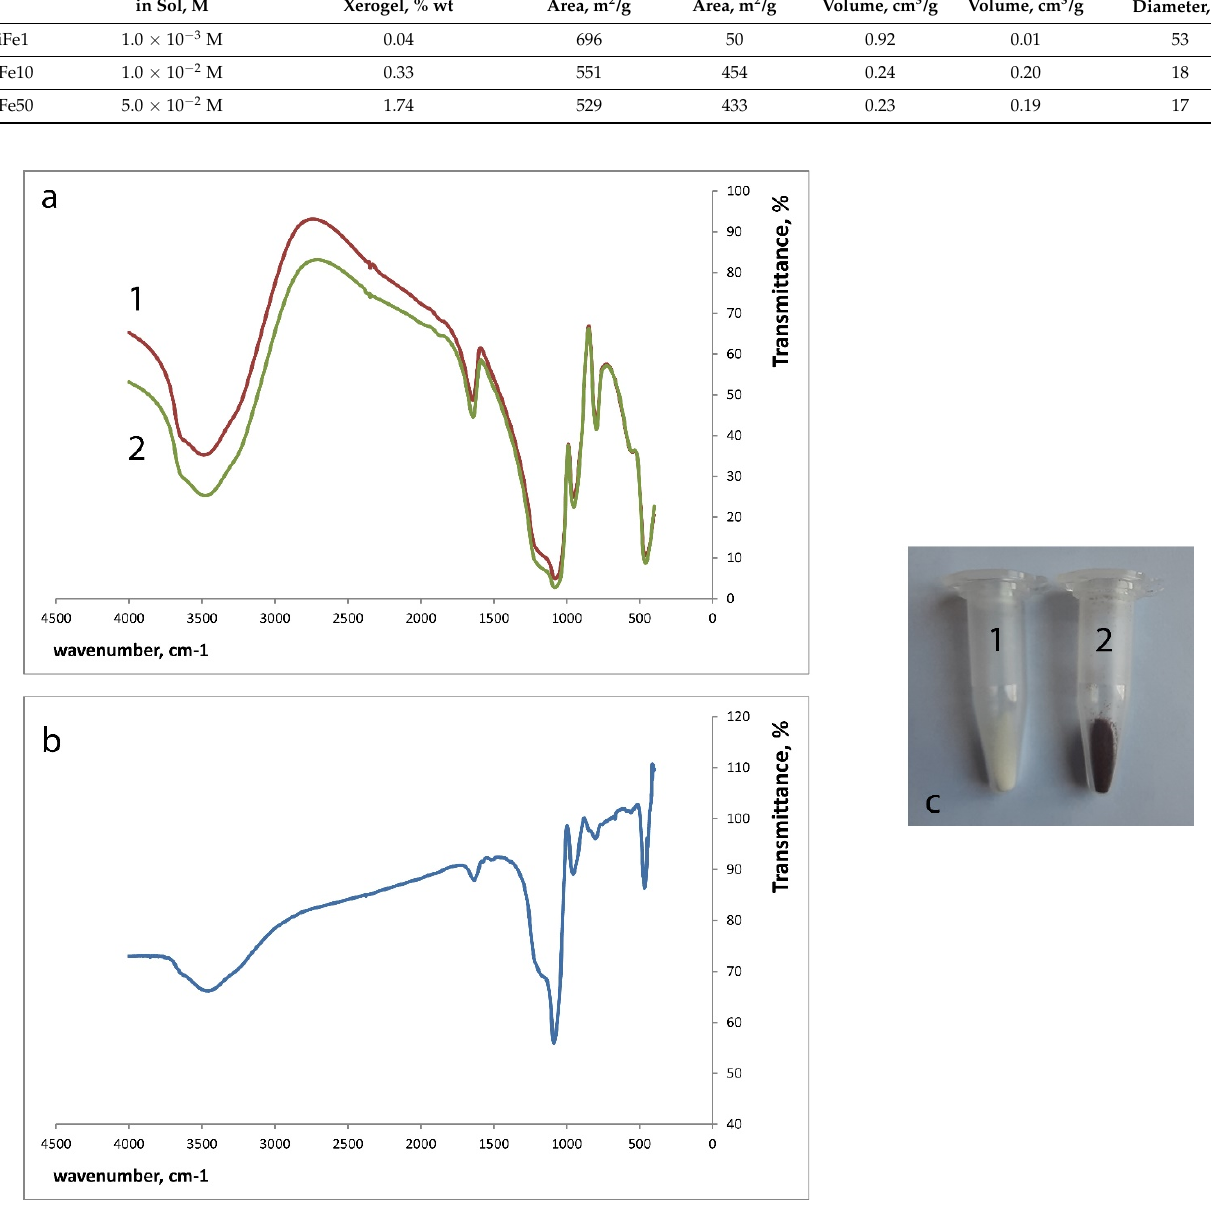
Figure 1. SiFe10 xerogel interaction with 5.0 ∙ 10 − 3 M salicylhydroxamic acid (SHA) (pH 3.3, time of contact 30 min), 1—SiFe10 xerogel, 2—SiFe10 xerogel after the interaction with SHA. ( a )—IR spectra of silica xerogels against KBr, ( b )—iFe10 xerogel after the interaction with 5.0 ∙ 10 − 3 M SHA IR spectrum against SiFe10 xerogel, ( c )—coloration of SiFe10 xerogel.